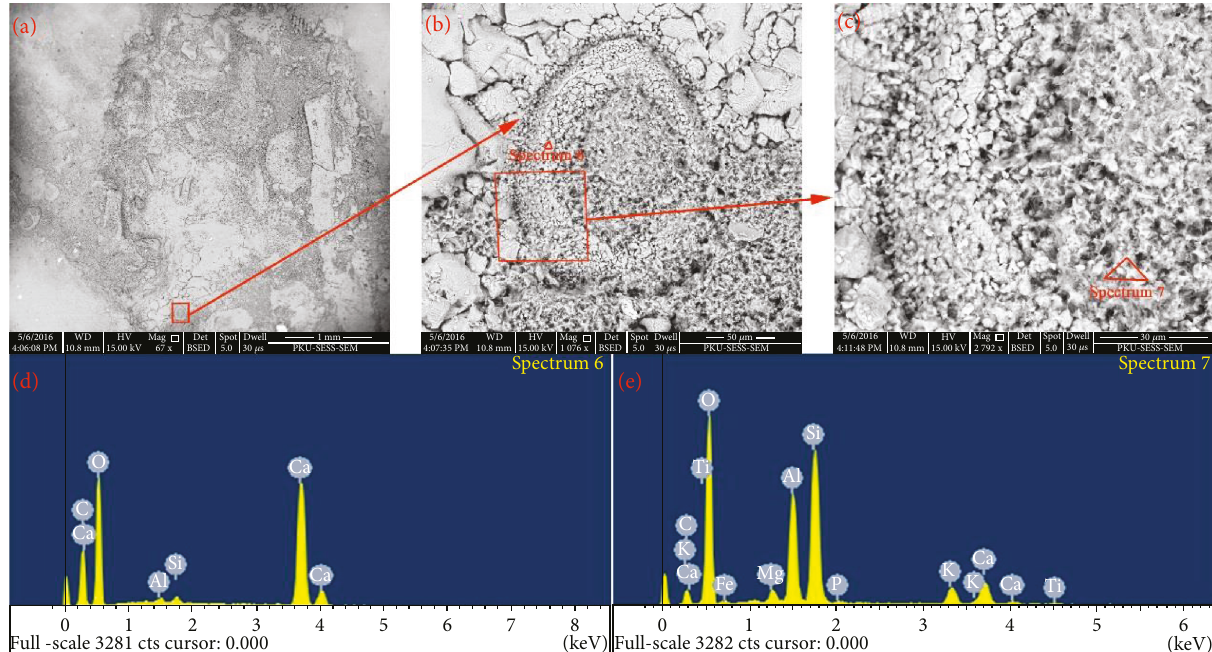
Figure 13: SEM photomicrographs of the bioclastic particles of S bioclastic particles. (c) More detailed view of the dissolved bioclastic particles. (d) EDS data of the triangle encircled part in (b). (e) EDS data of the triangle encircled part in (c).